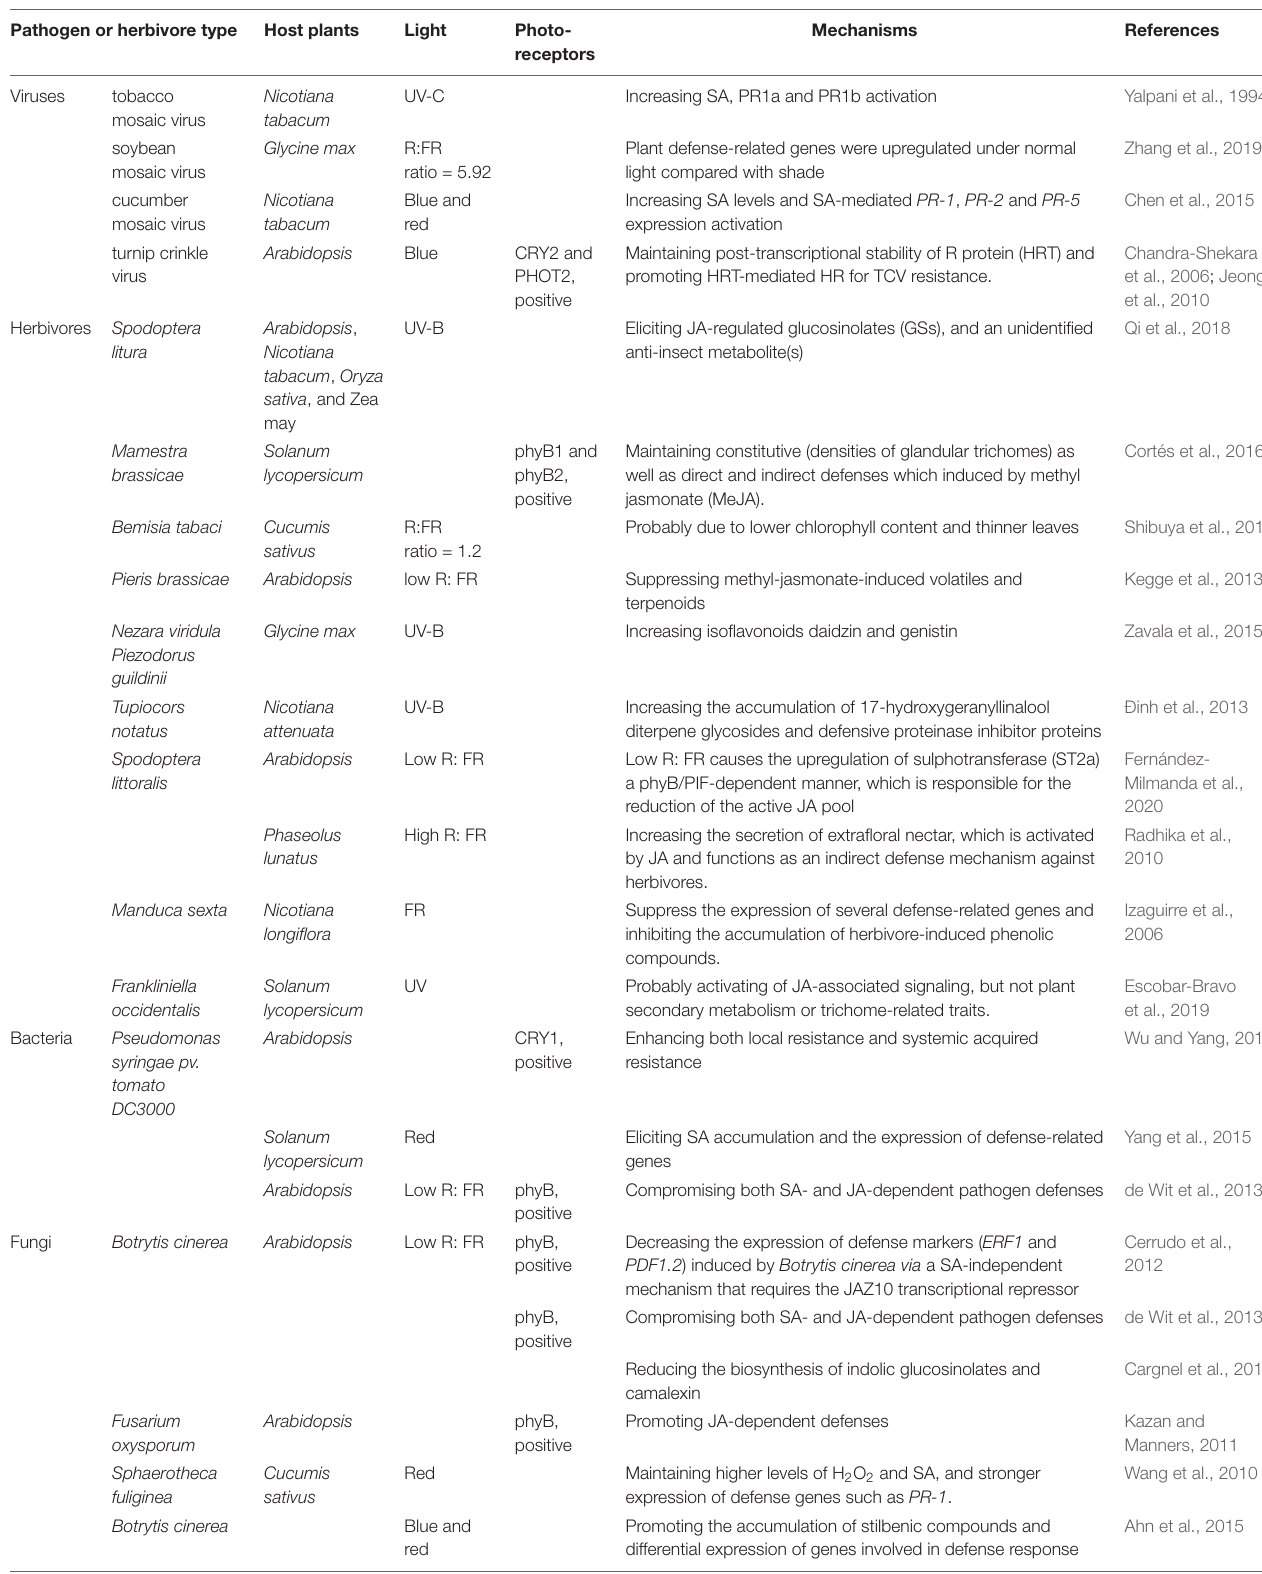
TABLE 1 | Light-mediated plant resistance to pathogens and